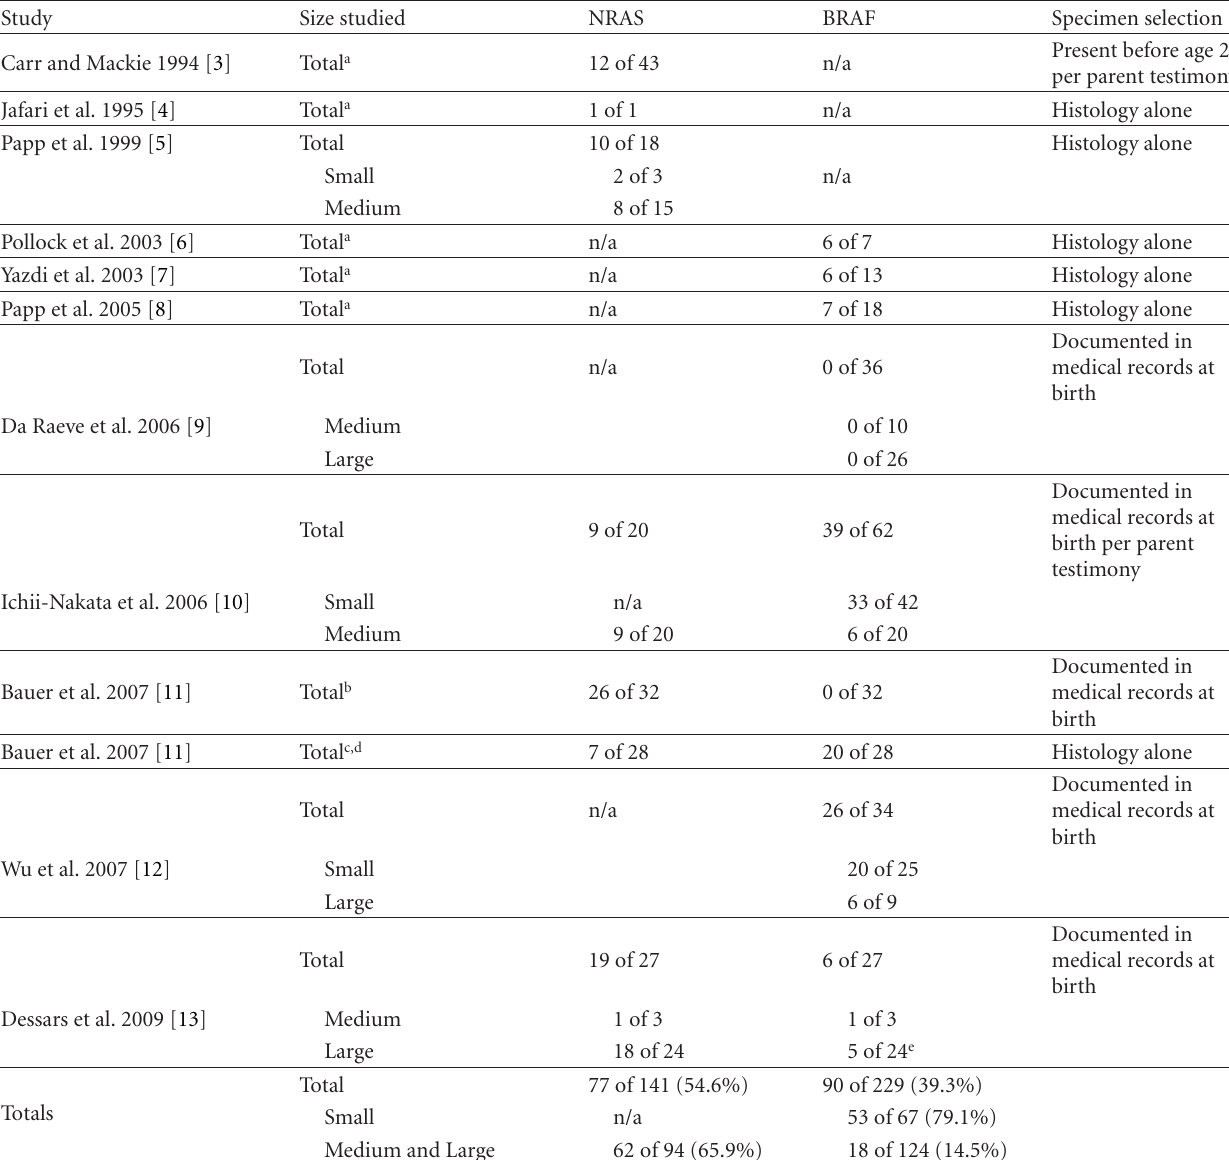
Table 1: Congenital melanocytic